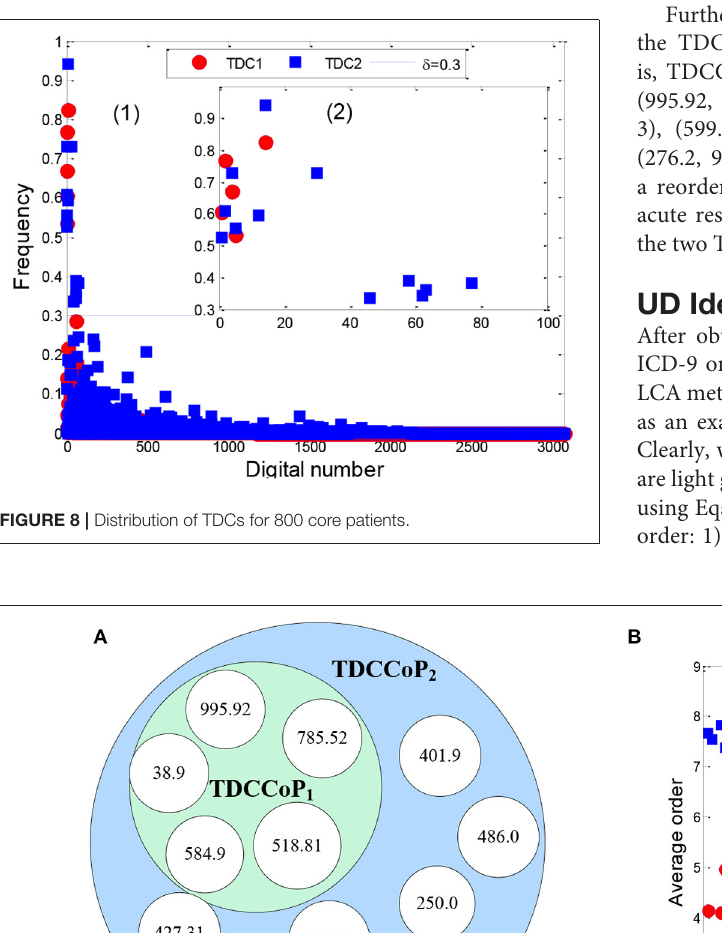
Frontiers in Public Health |